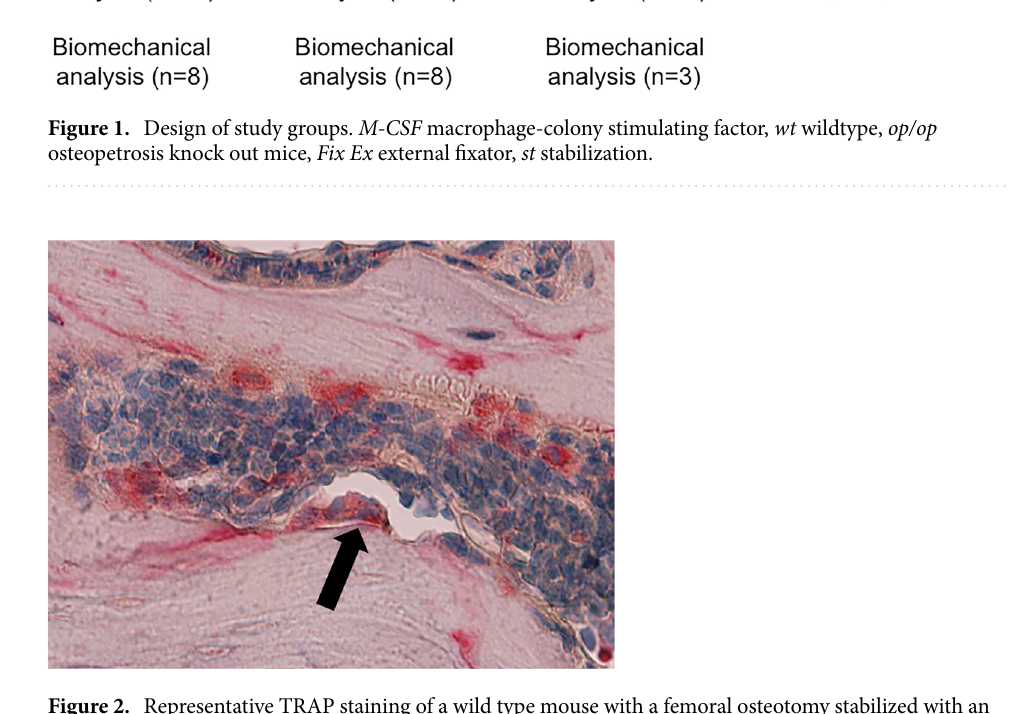
Figure 2. Representative TRAP staining of a wild type mouse with a femoral osteotomy stabilized with an external fixator. The arrow shows an osteoclast; original magnification: ×400 (source: Florian Körbler, diploma thesis, Medical University of